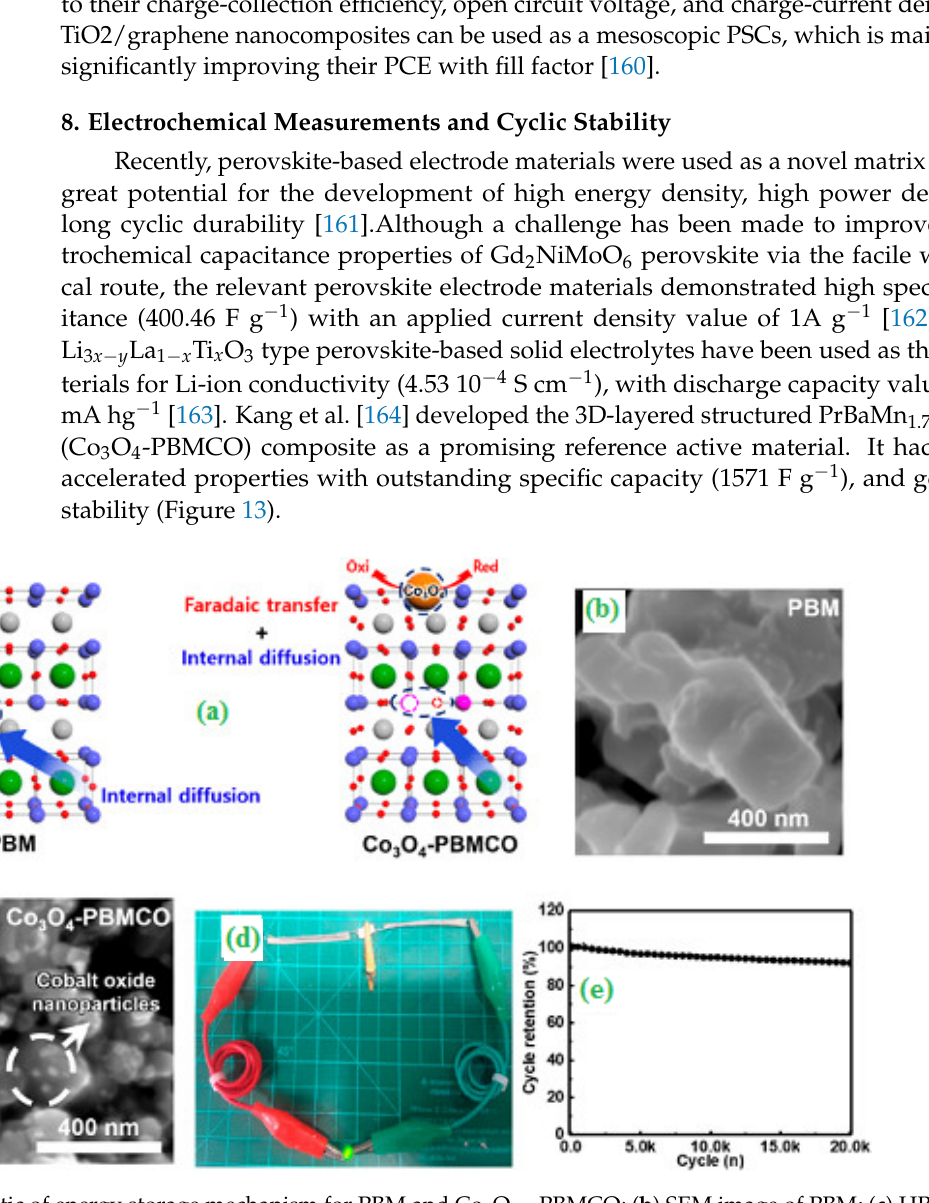
Figure 13. ( a ) Schematic of energy storage mechanism for PBM and Co 3 O 4 − PBMCO; ( b ) SEM image of PBM; ( c ) HR-TEM images of Co 3 O 4 -PBMCO; ( d ) digital-camera image of a green LED powered by two wire-type hybrid devices connected in series; and ( e ) cycling performance of the hybrid device for 20,000 cycles. Copyright 2020 by the American Chemical Society [164].